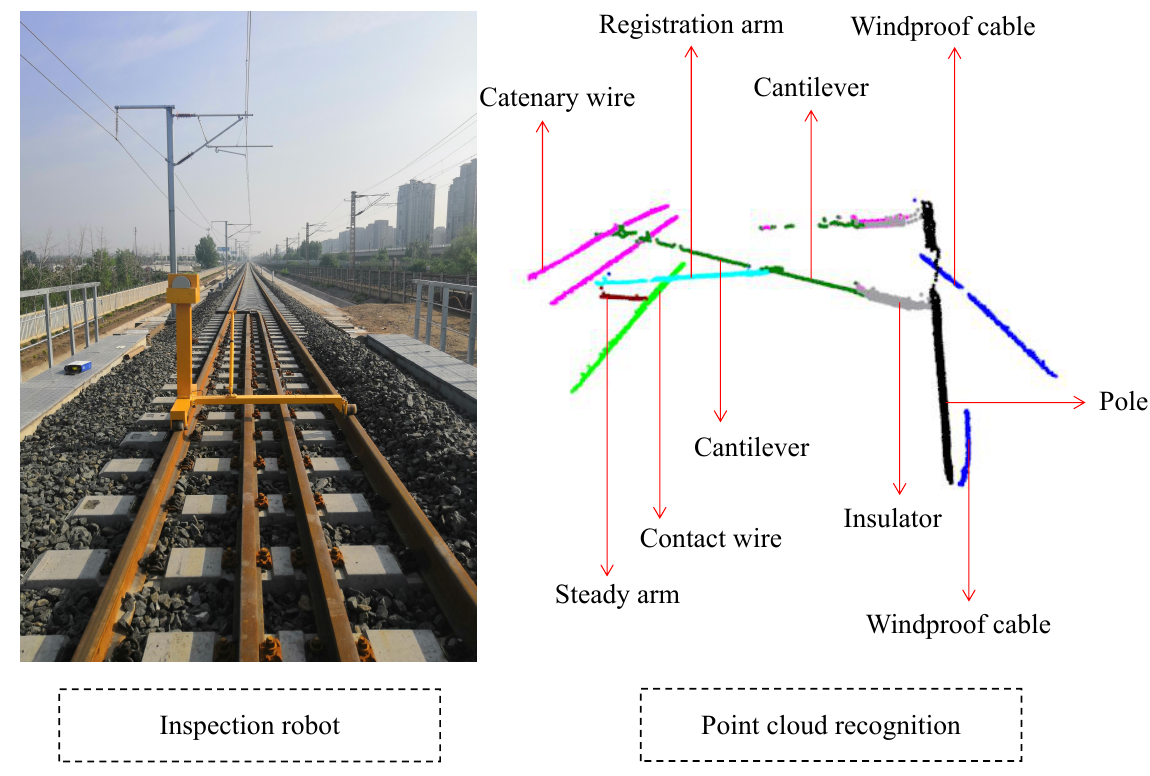
Figure 1. Recognizing an overhead contact